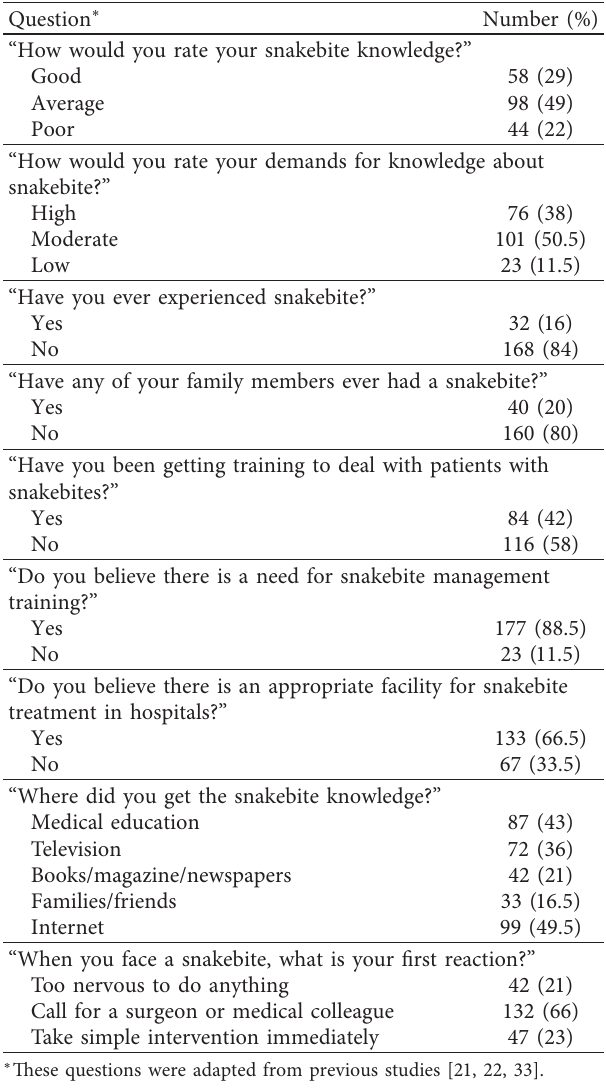
Table 2: Nursing students’ responses to self-assessment